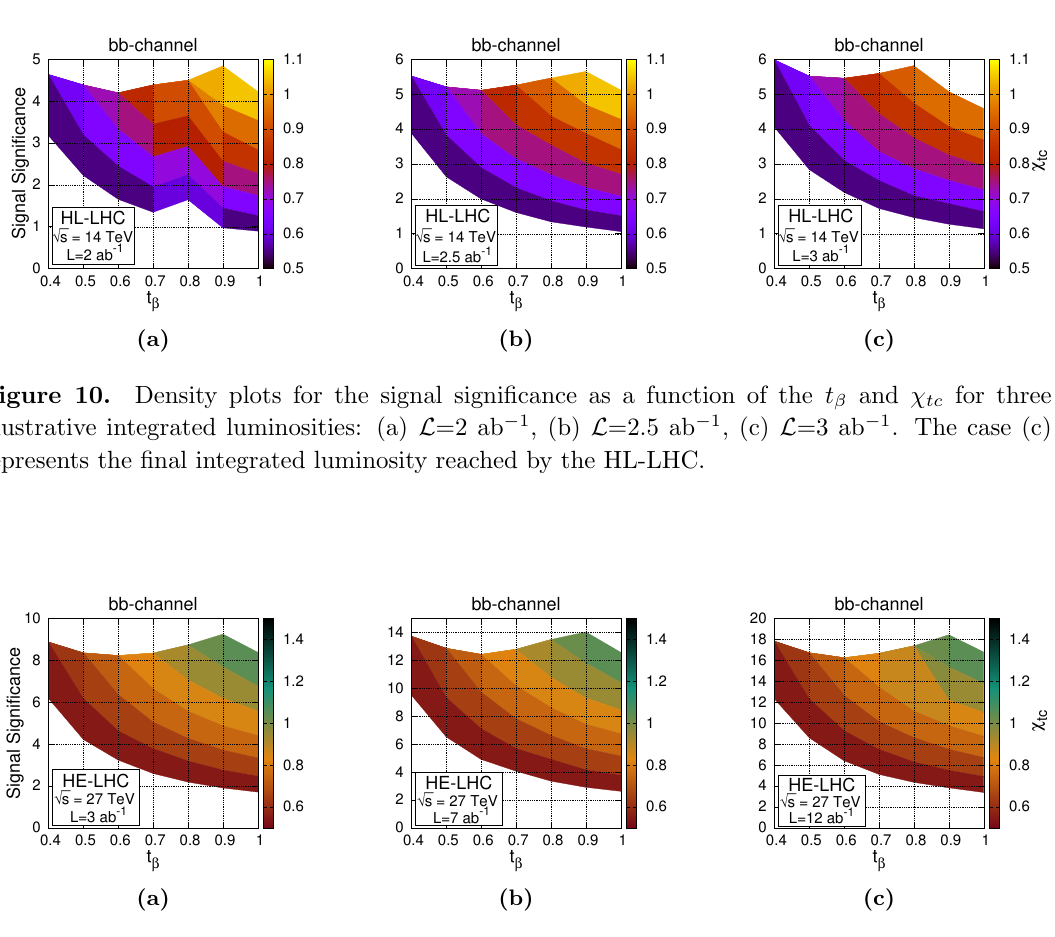
Figure 11. The same as in (cid:12)gure 10 but for: (a) L =3 ab (cid:0) 1 , (b) L =7 ab (cid:0) 1 , (c) L =12 ab (cid:0) 1 . The case (c) represents the (cid:12)nal integrated luminosity reached by the HE-LHC.